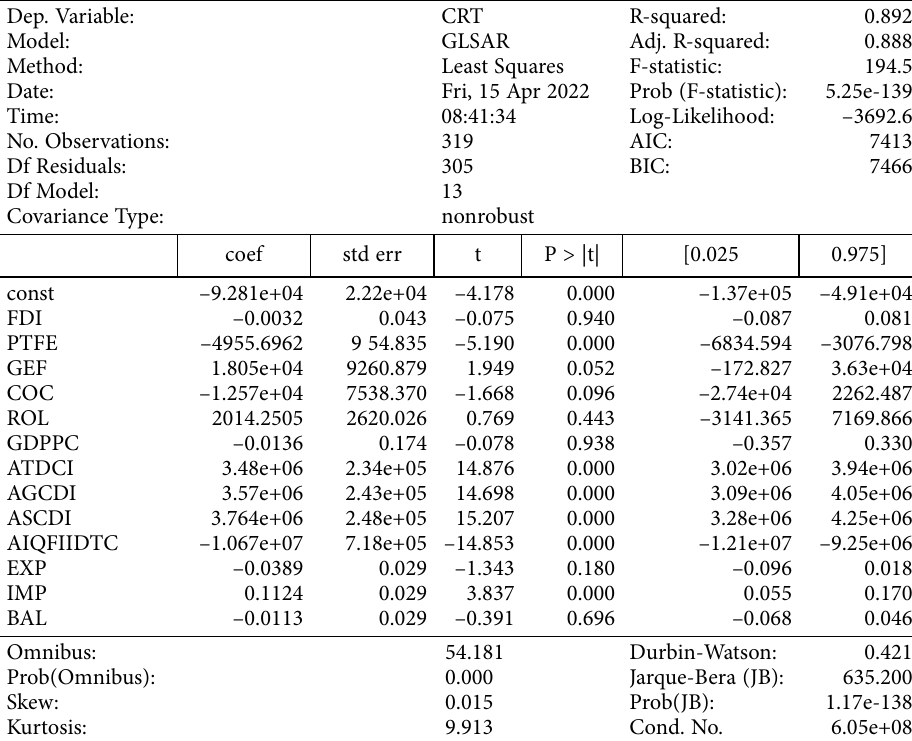
Table 8. GLSAR regression results – Part 1 (source: own processing using Python 3.0